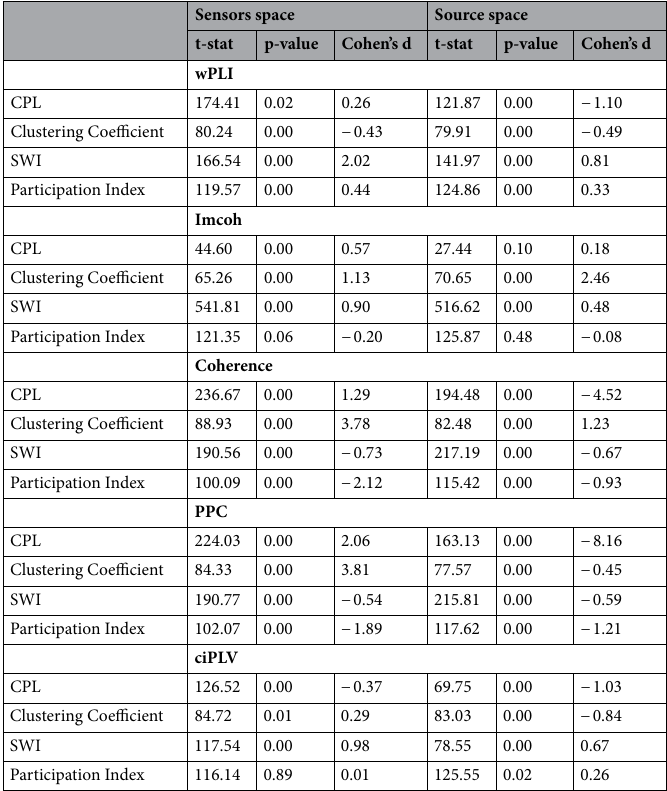
Table 2. T-statistic comparison between OMST-graph and thresholded graph of similar